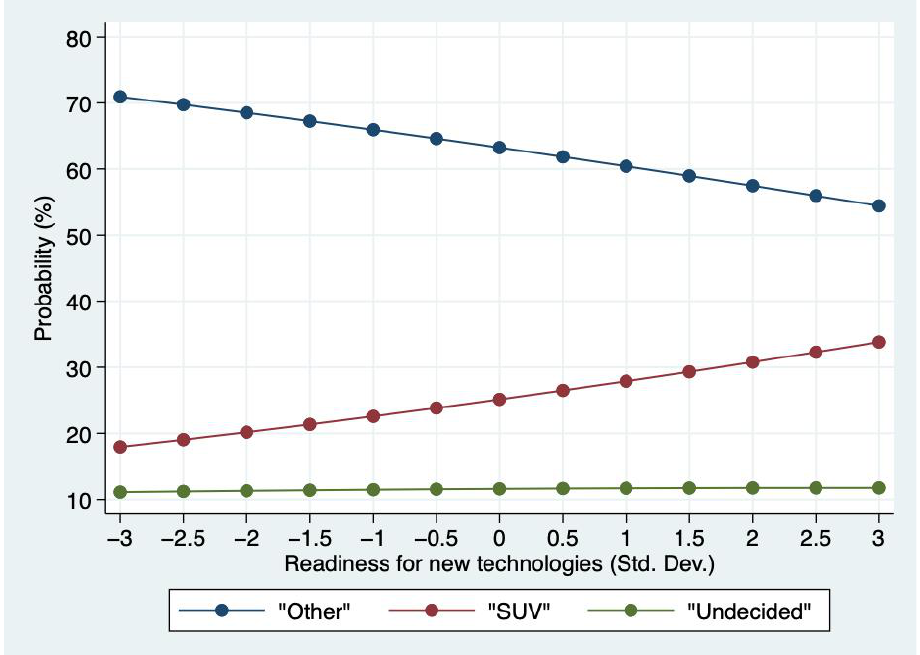
Figure 2. Predictive margins. Readiness for new technologies.